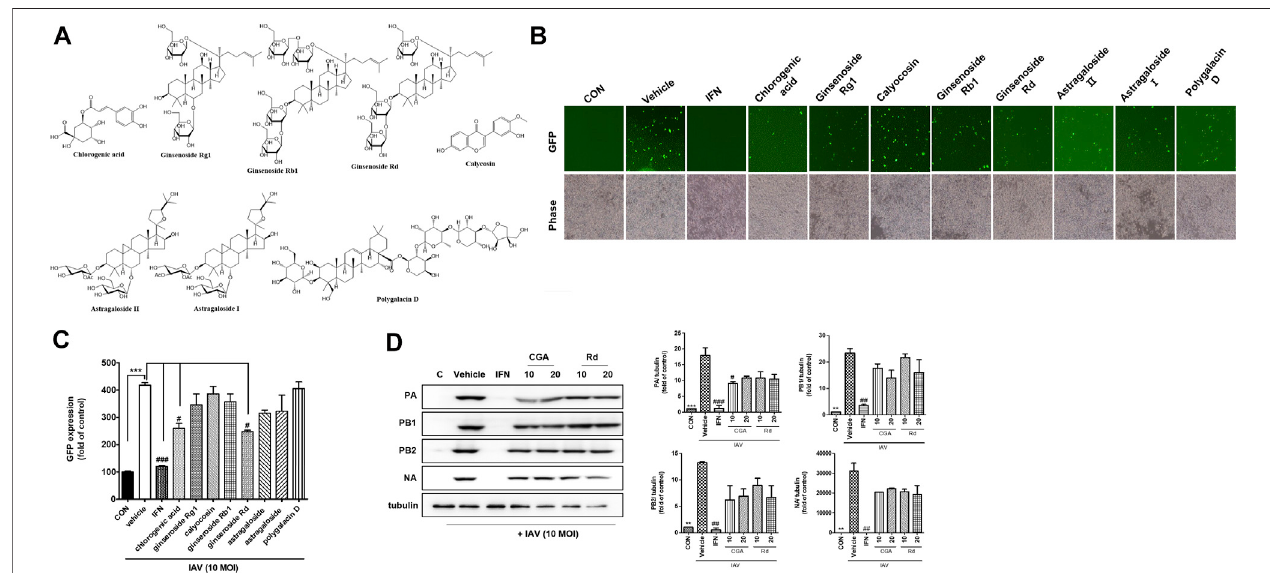
FIGURE 6 | The antiviral effects of the eight major components identi fi ed in OCD20015-V009 on RAW 264.7 murine macrophages infected with in fl uenza A virus (IAV). (A) The eight major components identi fi ed in OCD20015-V009: chlorogenic acid, ginsenoside Rg1, calycosin, ginsenoside Rb1, ginsenoside Rd, astragaloside II, astragaloside I, and polygalacin D. (B) RAW 264.7 cells were incubated with the medium alone, 10 μ M of a major component of OCD20015-V009 or 1000 U/mL recombinant mouse interferon- β 12 h before infection with A/PR/8/34-GFP at the multiplicity of infection of 10. The images of GFP levels were obtained 24 h after virus infection. (C) The GFP levels and reduction in viral replication in RAW 264.7 cells pre-treated with the eight major components of OCD20015-V009 24 h after viral infection were assessed using fl ow cytometry. The bar graphs are plotted with the data from three experiments. *** p < 0.001 compared with the control, # p < 0.05 and ### p < 0.001compared withthevehicle(IAV-infection). (D) TheleveloftheIAVproteinsinRAW264.7cellsasassayedbyWesternblotsusingantibodiesagainstvarious IAV proteins. RAW 264.7 cells were pre-treated with 10 and 20 μ M chlorogenic acid or ginsenoside Rd, 1000 U/mL recombinant mouse interferon (IFN)- β , or the medium only (negative control) after viral adsorption. The levels of IAV proteins PA, PB1, PB2, and NA in the cell lysates were analyzed with Western blots; the level of tubulin was used as the internal control. Western blotting of viral expressions and then quanti fi cation using the ImageJ software. The data are presented as the mean ± SD (error bars) of three independent experiments. ** p < 0.01 and *** p < 0.001 indicate a signi fi cant difference between control groups, # p < 0.05, ## p < 0.01 and ### p < 0.001 indicate a signi fi cant difference between the vehicle